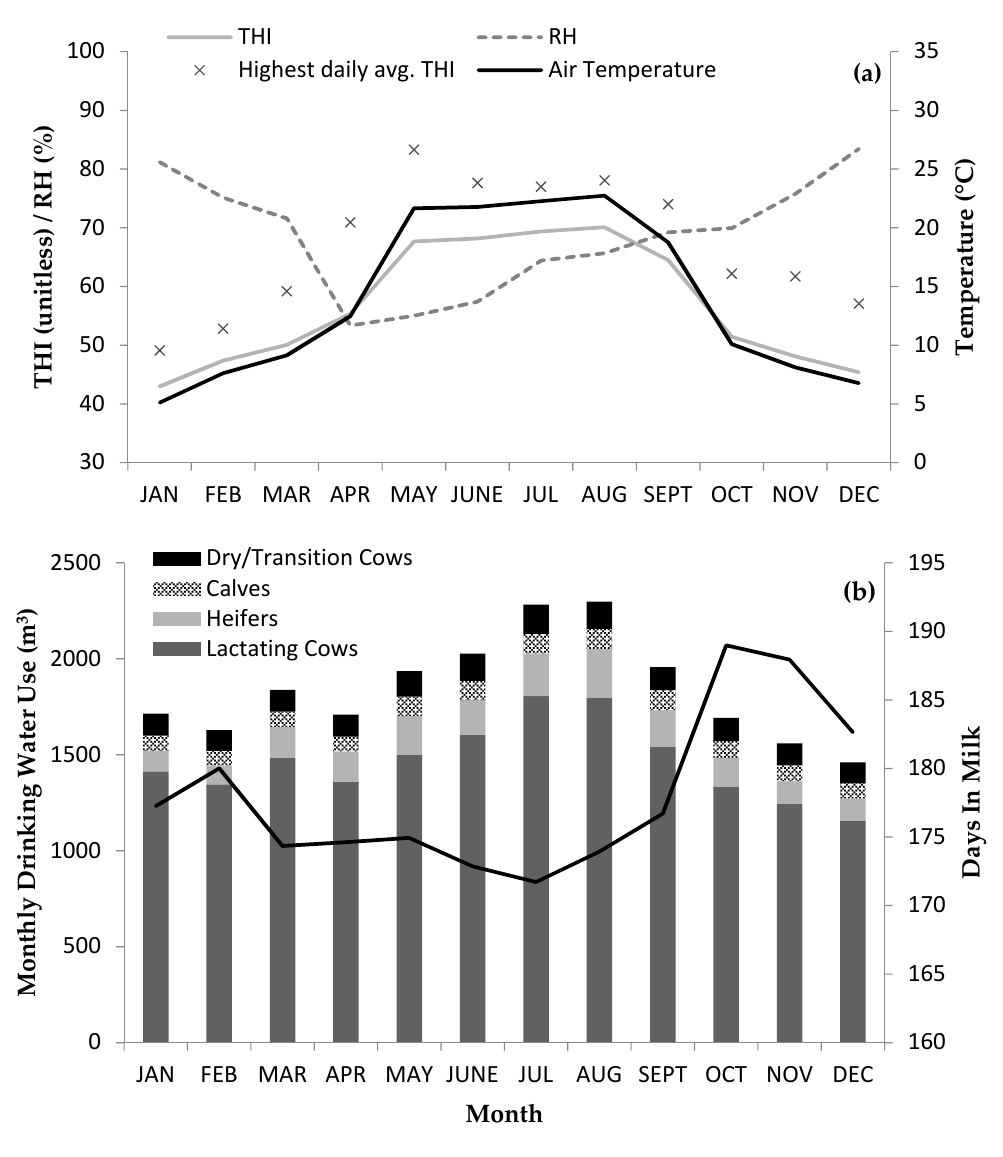
Figure 2. ( a ) Average monthly THI and air temperature (°C). ( b ) Total monthly drinking water consumption (m 3 ) broken down by animal category (lactating cows, dry/transition cows, calves and heifers). The solid line is the average monthly days in milk (DIM).